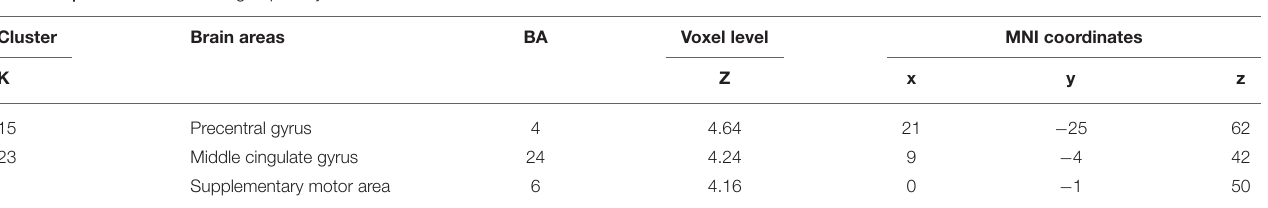
TABLE 4 | Peak coordinates of group analysis. Cluster Brain